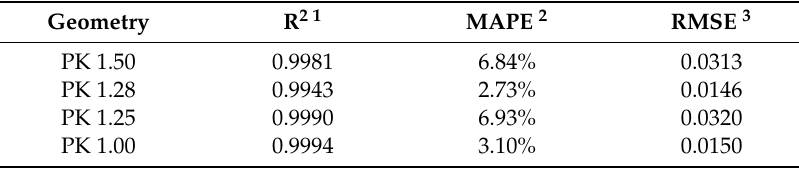
Table 4. Values of R 2 , MAPE, and RMSE corresponding to Equation (2).